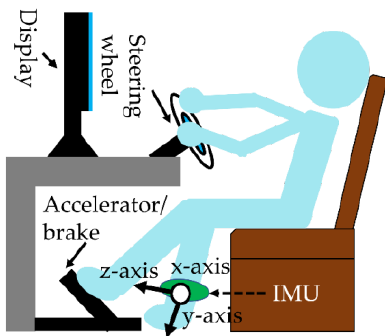
Figure 8. Subject drives on the route with a driving simulator.